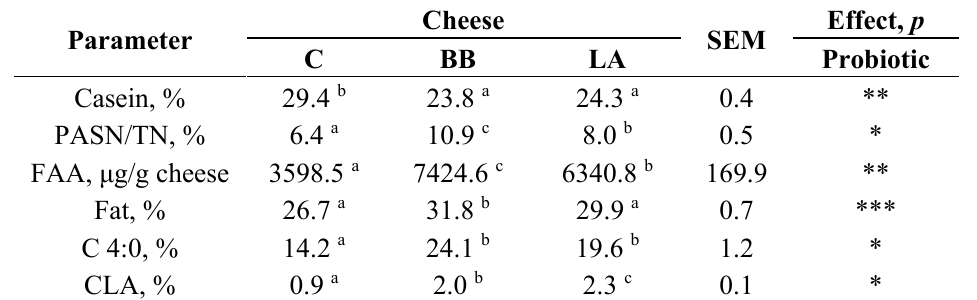
Table 1. Chemical composition of probiotic ovine cheese at 45 day of ripening ( n = 18). Parameter